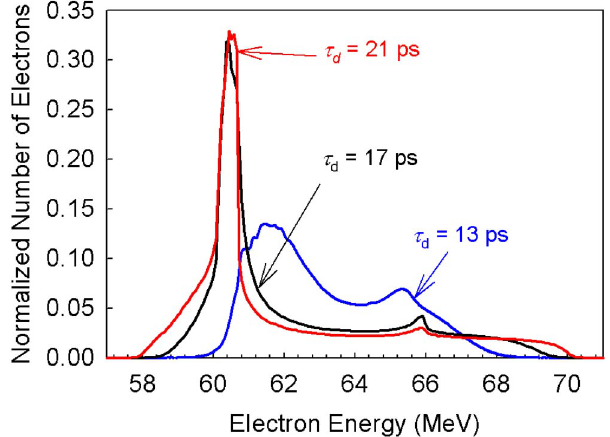
FIG. 7. (Color) Model prediction for energy spectrum of witness (cid:1) 8 : 91 ps and different time delays between the bunch for t d seed and witness e -beam bunches for an acceleration length (cid:1) 3 mm . L acc